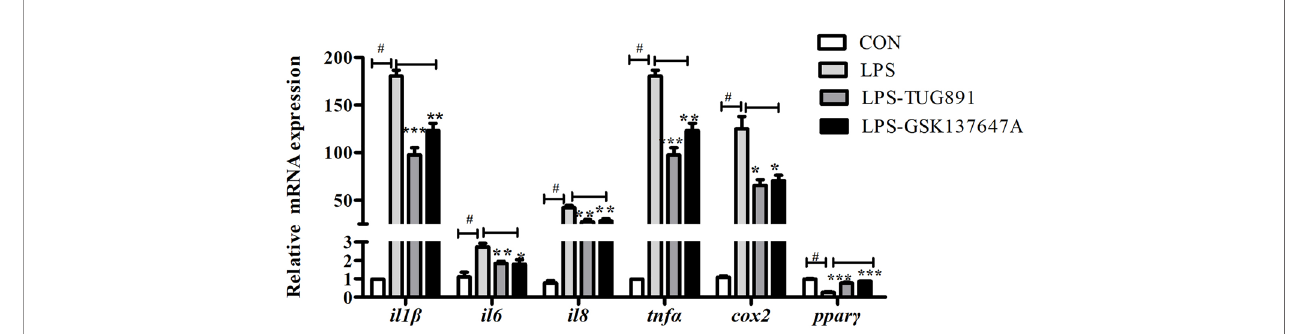
FIGURE 2 | Effects of FFAR4 agonist TUG891 or GSK137647A on the expression of LPS-induced il1 b , il6, il8 , tnf a , cox2 and ppar g in macrophages of large yellow croaker. Data were shown as mean ± S.E.M. (n = 4). # P < 0.05, * P < 0.05, ** P < 0.01, *** P < 0.001.